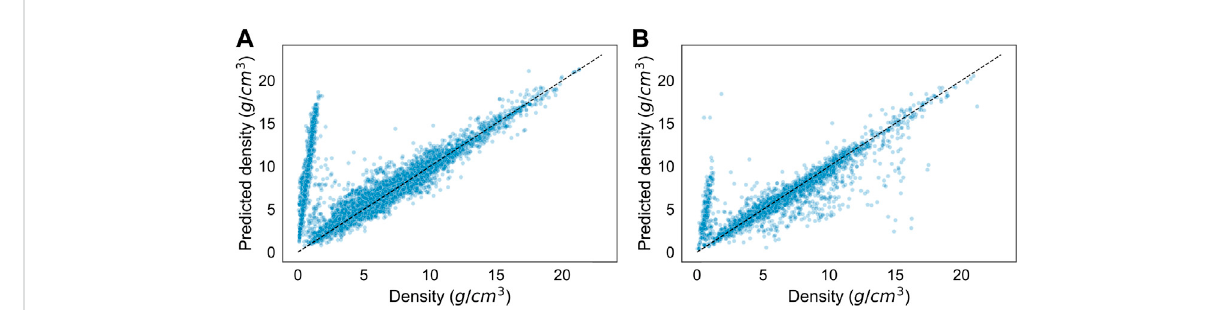
FIGURE 4 Resultsofextrapolationtocrystalswithhigherenergiesabovehull. (A) Resultsoftheregressionmodelpredictingdensities(g/cm 3 )ofallcrystals